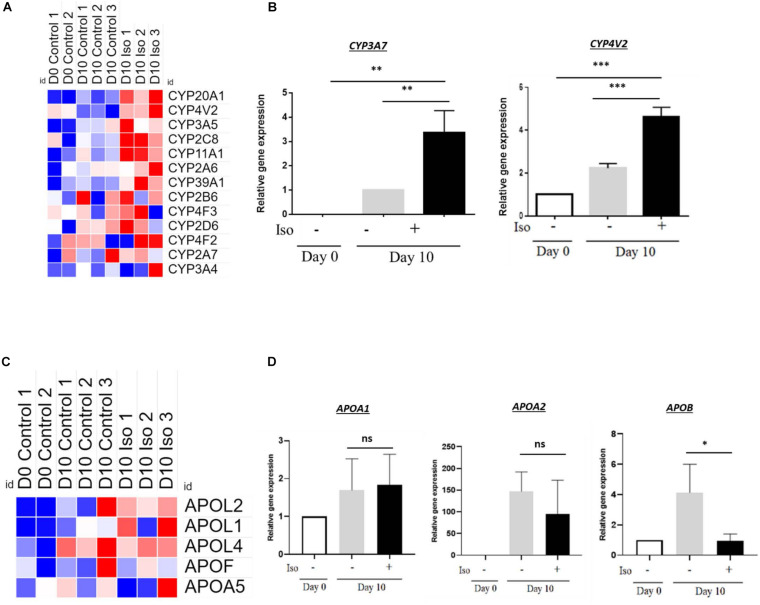
(A) Heatmap showing signal intensities (log2) of CYP enzymes (from microarray analysis), (B) Relative gene expression of CYP enzymes. (C) Heatmap showing signal intensities (log2) of APO genes (from microarray analysis), (D) Relative expression levels of APO genes. *P < 0.05, **P < 0.01, ***P < 0.001, ns: not significant.